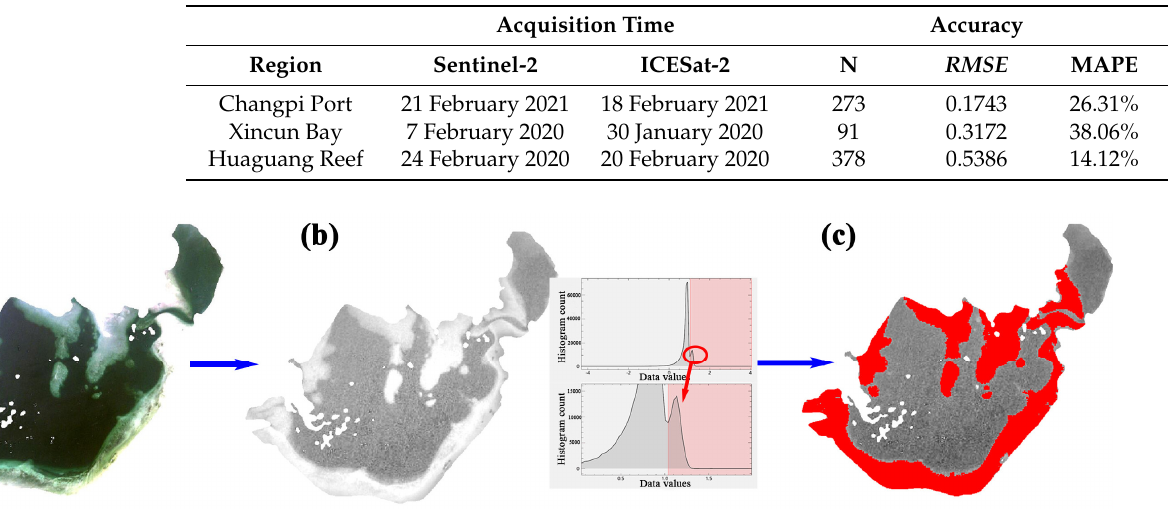
Table 3. The Acquisition Time of Sentinel-2 and ICESat-2 and the Accuracy Assessment for Three Regions.